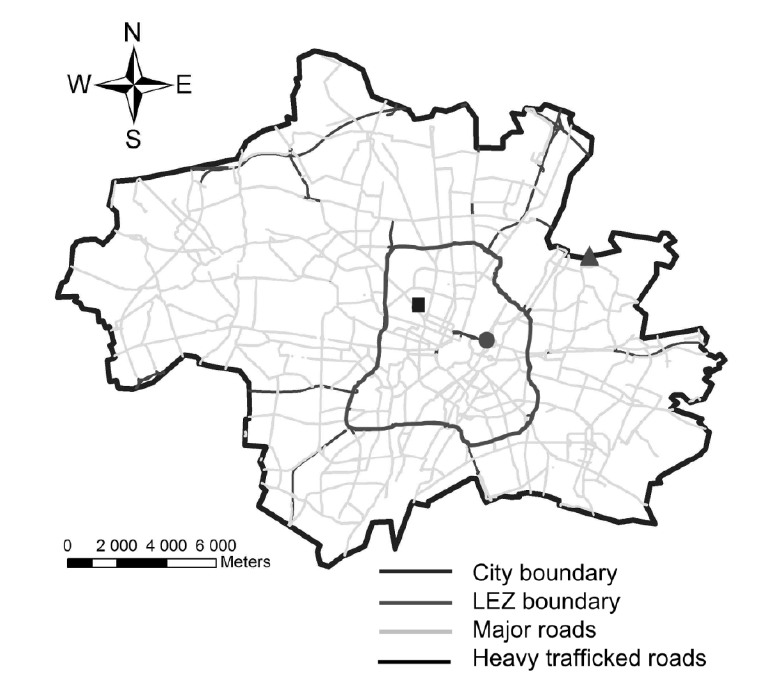
Figure 1. Locations of the LÜB monitoring sites in Munich,